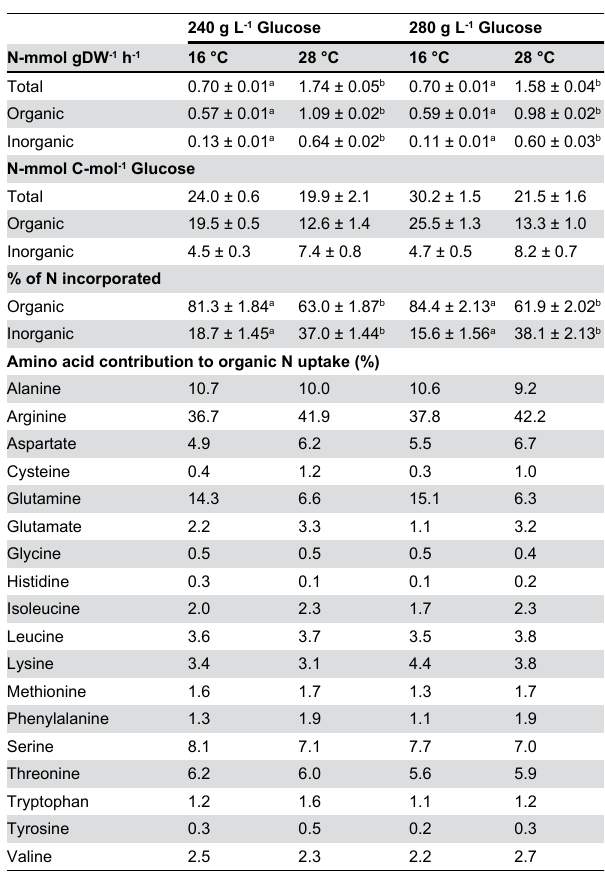
Different superscripts indicate statistically significant differences between values (p <